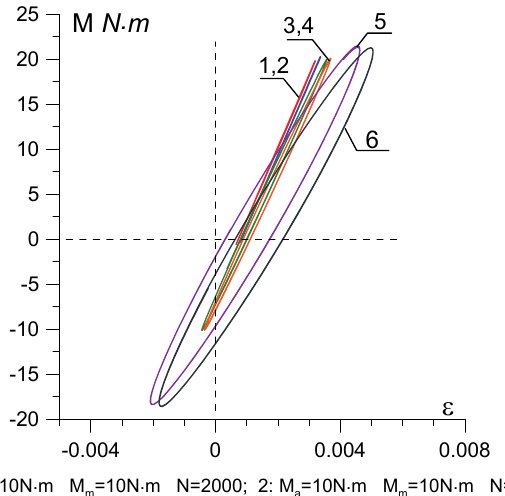
Figure 8: Hysteresis loops at the decreasing mean load